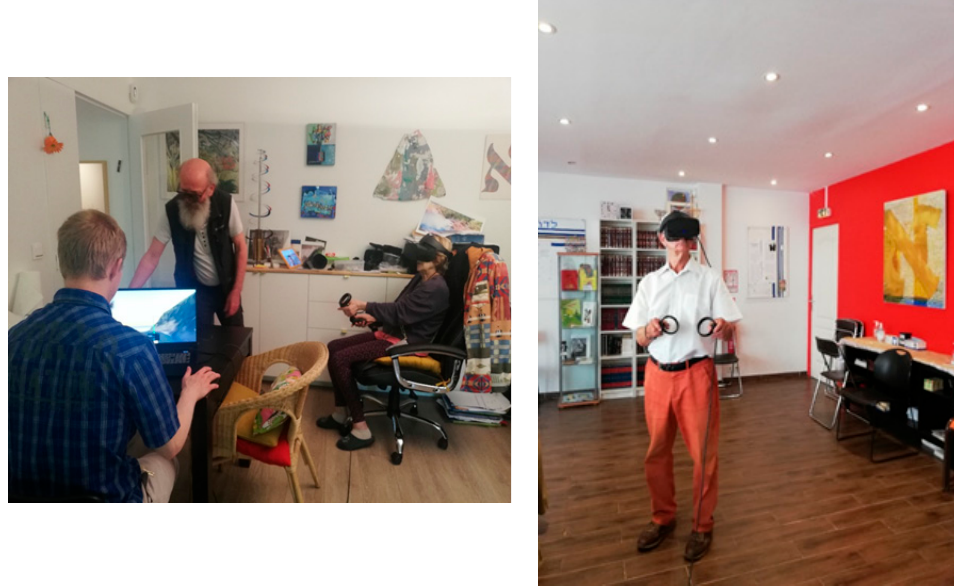
Figure 9. Photographic snapshots of the experimentation session with our elder subjects.